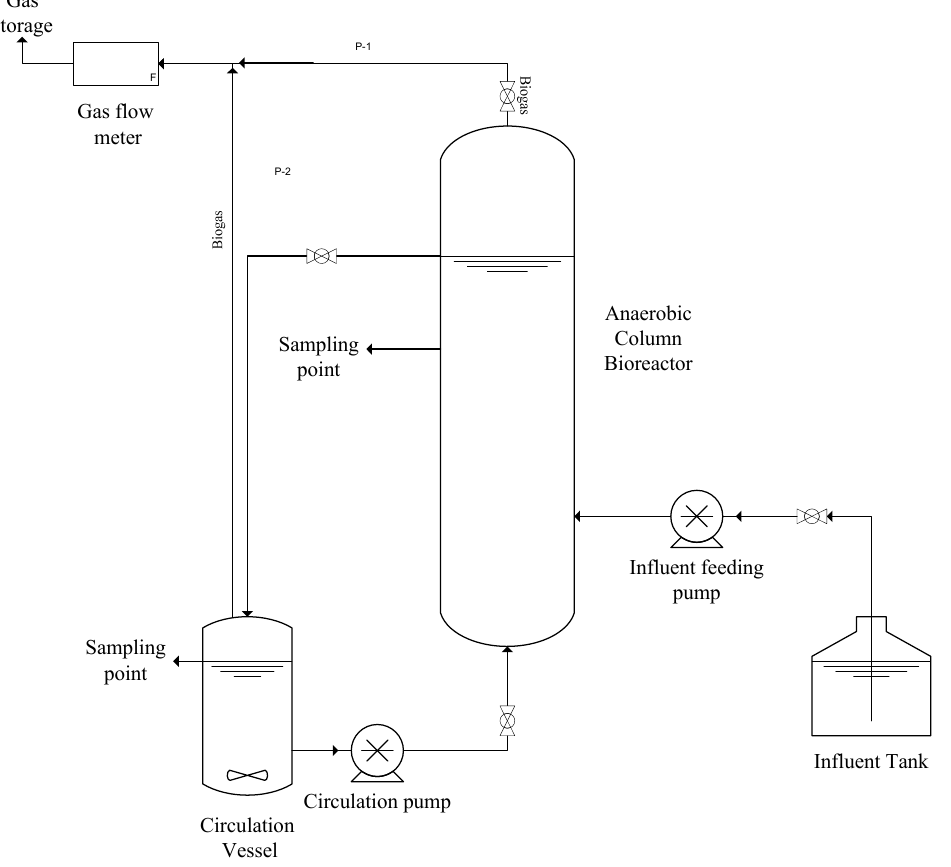
Figure 1. 1.5 L anaerobic column bioreactor (ACBR) set up for biohydrogen fermentation.